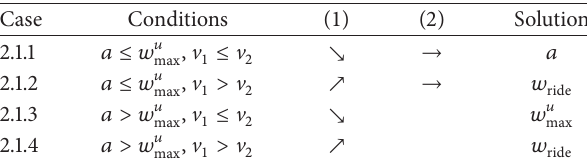
Table 7: Case 2.1